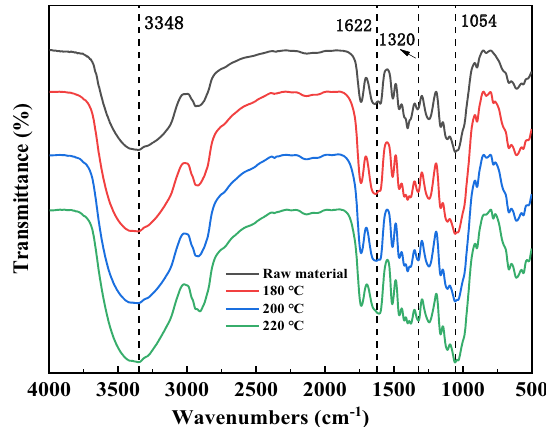
Fig. 9 FTIR of raw materials and binderless boards at different temperatures of Broussonetia